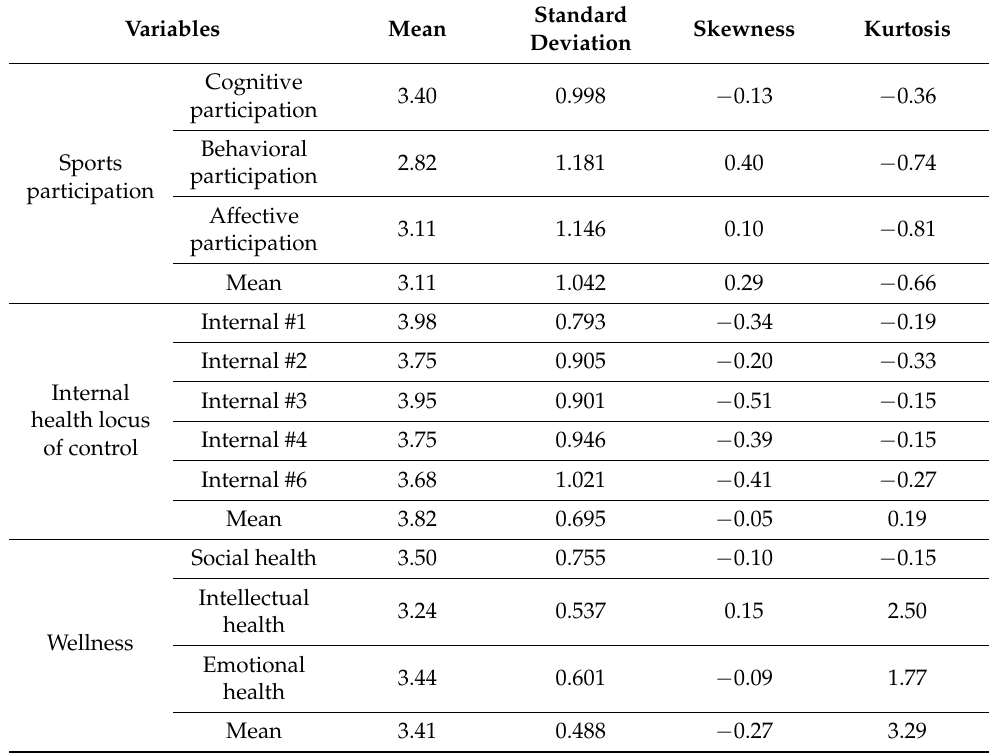
Table 4. Descriptive statistics (five-point Likert scale).